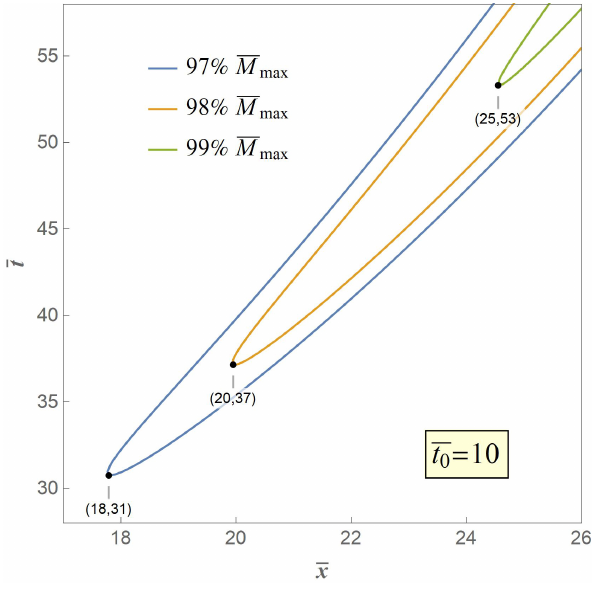
Figure 8. Contour curves when M = 97%,98%,99% M max at t 0 =